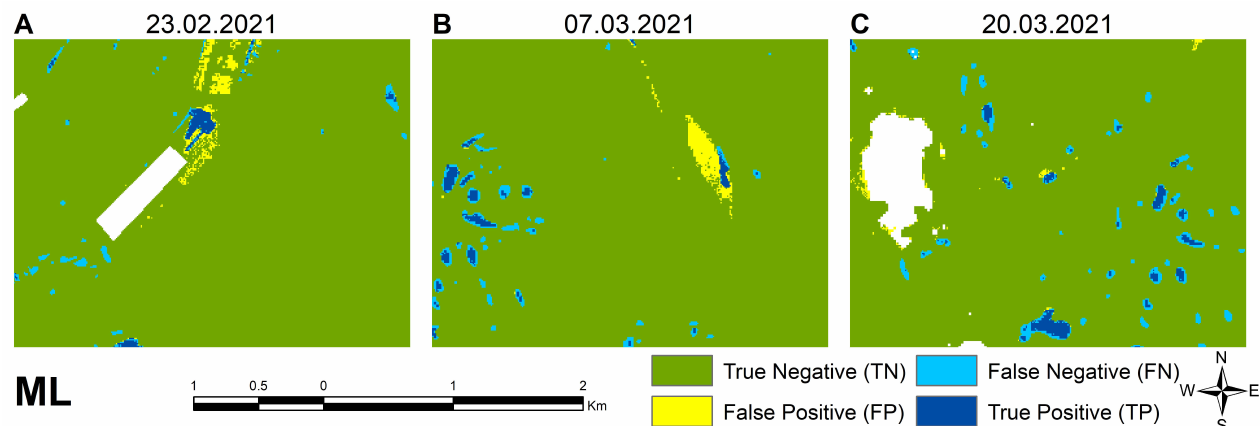
Figure 12. Examples of maximum likelihood model classification errors at different times, including ( A ): Omission in reference map 23 February 2021; ( B ): shallow water 7 March 2021; and ( C ): cloud and shadow mask and shallow water 20 March 2021.